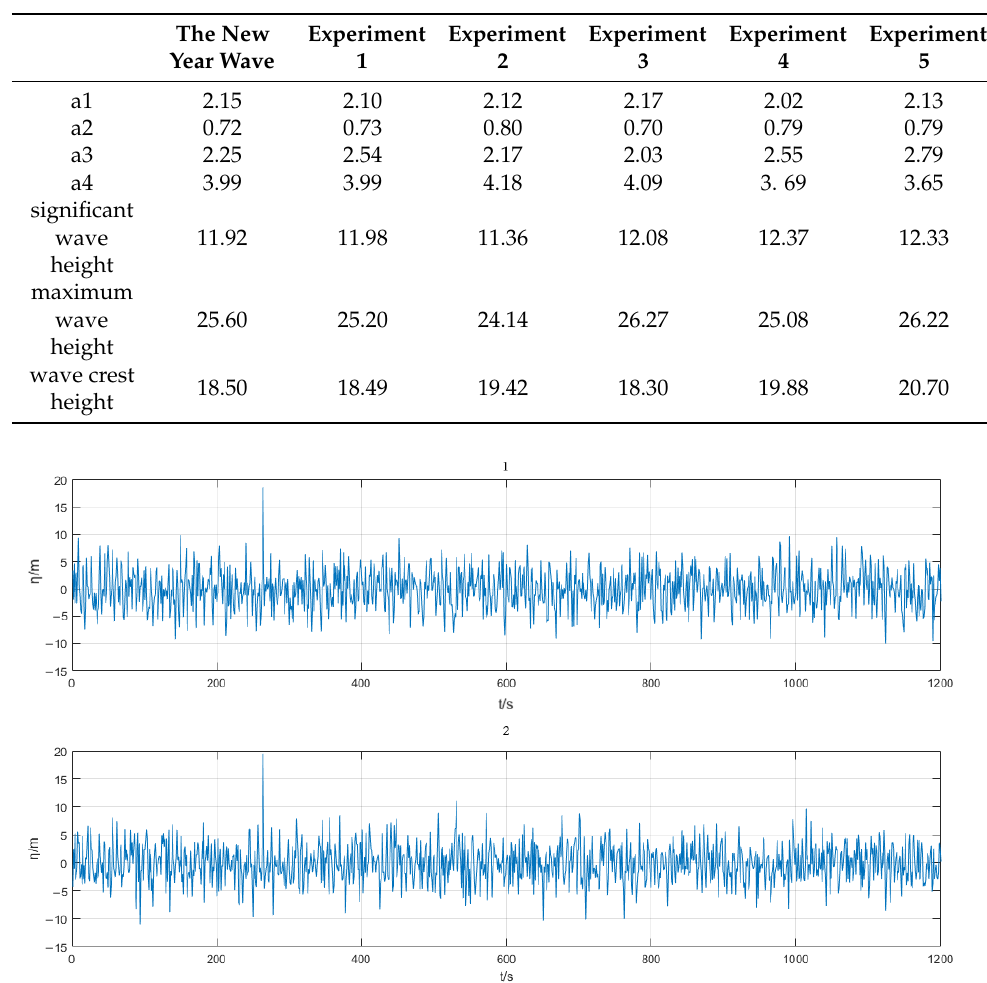
Table 4. Comparison of parameters between the measured “New Year Wave” and the numerical simulation “New Year Wave”.